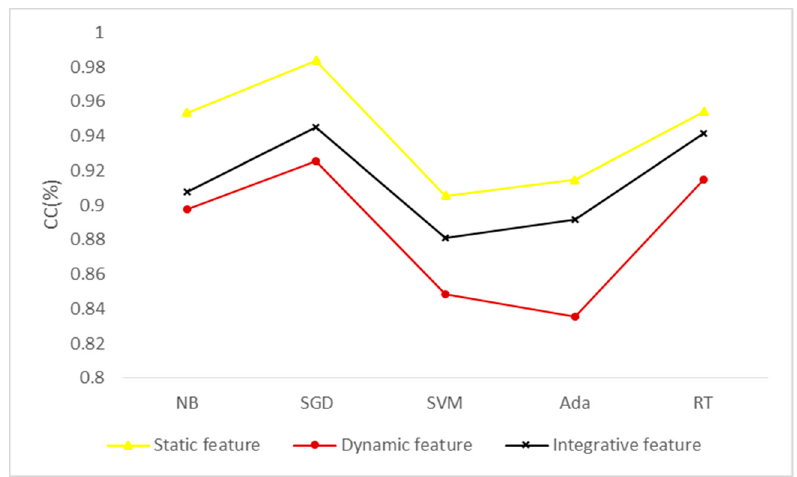
Figure 5. Classification effect of different types of features under different algorithms. CC (Correctly Classified rate, CC), NB (Naive Bayes, NB), SGD (Stochastic Gradient Descent, SGD), SVM (Support Vector Machine, SVM), Ada (Adaboost, Ada) and RT (Random Trees, RT).